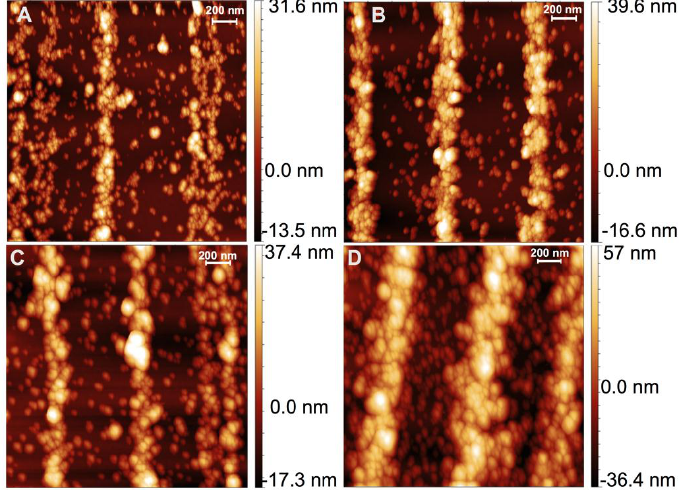
Figure 3. Atomic Force Microscopy (AFM) images of nanoparticle self-assembly onto the same features imaged with SEM in Figure 1, for different coating times: ( A ) 5 min; ( B ) 15 min; ( C ) 30 min; and ( D ) 60